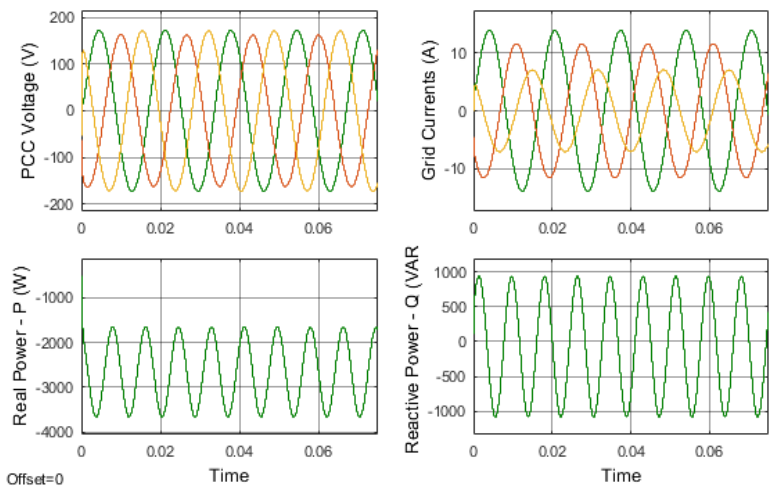
Figure 4. The ripple in real and reactive power for an unbalanced weak